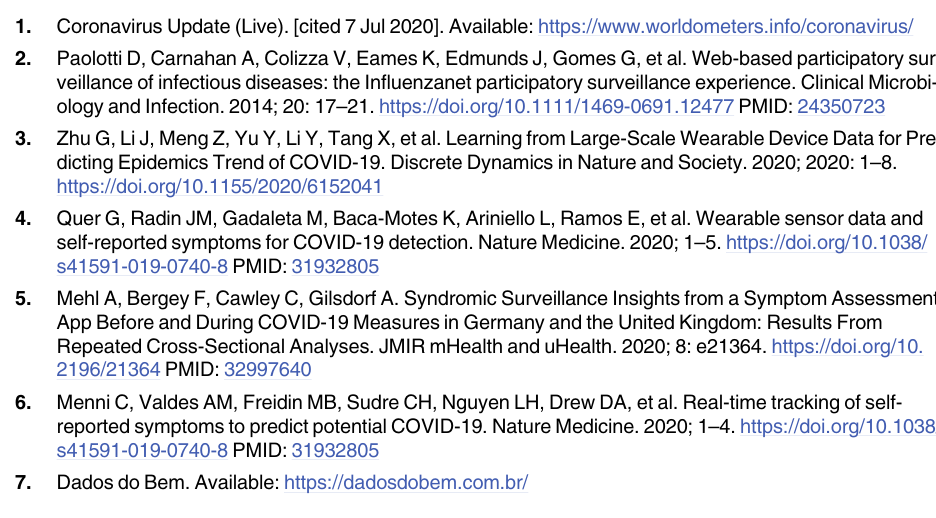
S2 Fig. Probability density function and frequency of the predicted values by the model using a testing set, compared to the real (observed) values. The black vertical line corre- sponds to the cut-off of 0.5, and the colored dashed vertical lines correspond to the expected average probability for the group of negative (red) and positive (blue) groups. S1 Table. Performance of the ML models computed from the independent test set for each